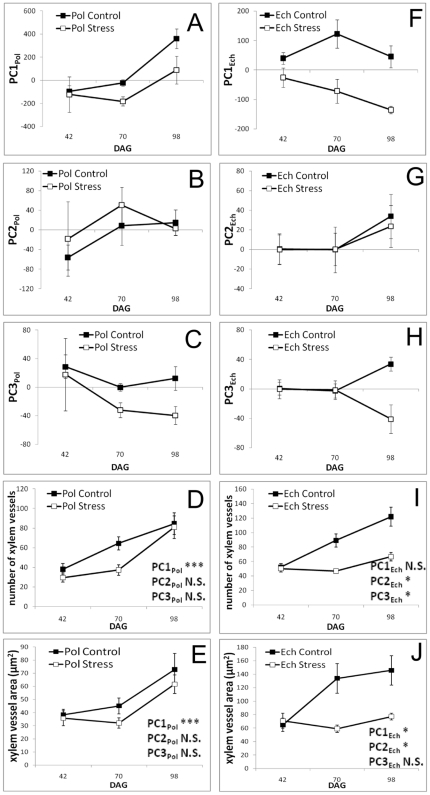
Quantification of the morphology and the anatomy in cacti seedlings.
A–C: The morphology of Polaskia chichipe expressed as PCPol. D–E: The number and area of xylem vessels in Polaskia chichipe. F–H: The morphology of Echinocactus platyacanthus represented as PCEch. I–J: The number and area of vessels in Echinocactus platyacanthus. D–E,I–J: Significant PCs from the regression yi = βPC1+βPC2+βPC3+εi are highlighted. * p<0.5, *** p<0.0005. Error bars represent standard error. DAG: days after germination.